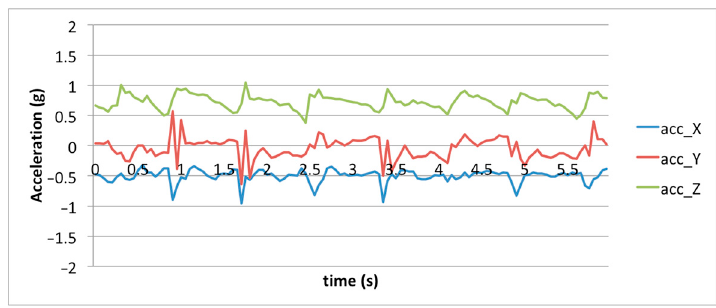
Figure 7. Accelerometer data acquired during shuffling gait.